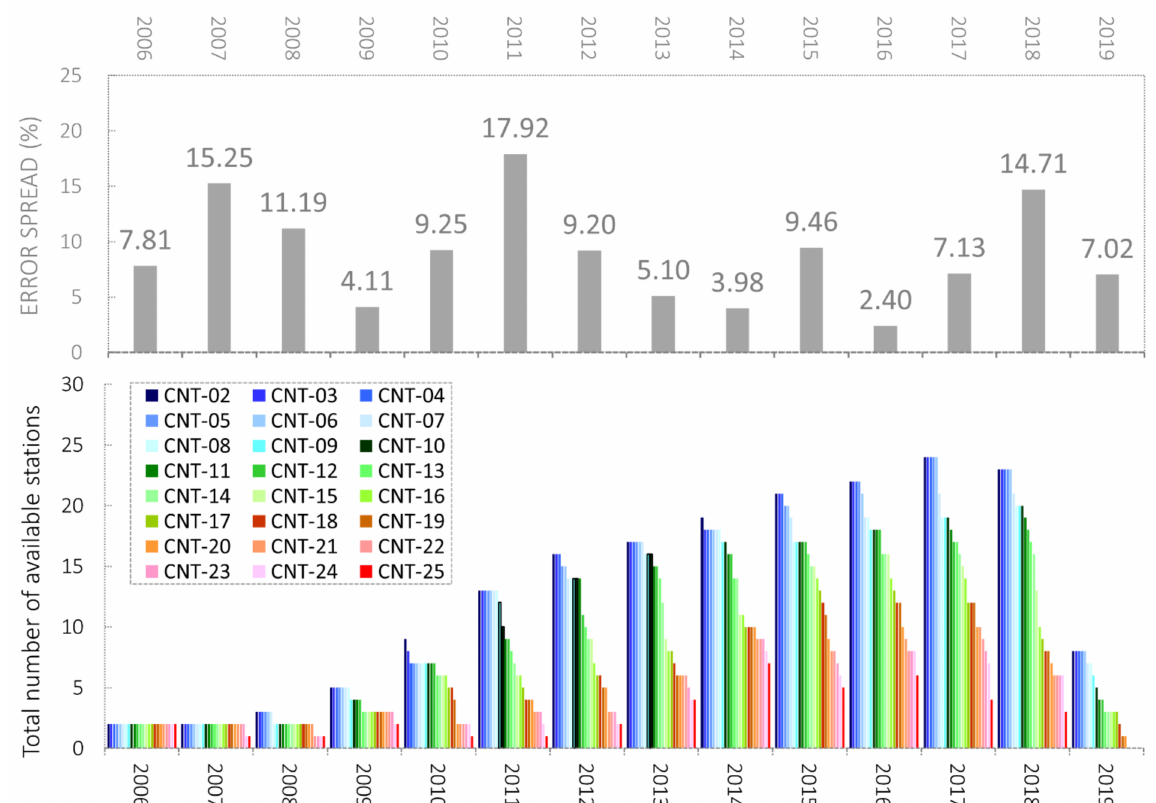
Figure 5. Bottom panel: Total number of TCCON stations remained, as a result of threshold-based filtering (denoted as CNT-i format where i stands for the minimum threshold), are shown by colored bars. Top panel: potential error spread across hypothetical AGR global estimates (gray bars) stemming from the range of used threshold (for MGR calculation) shown by